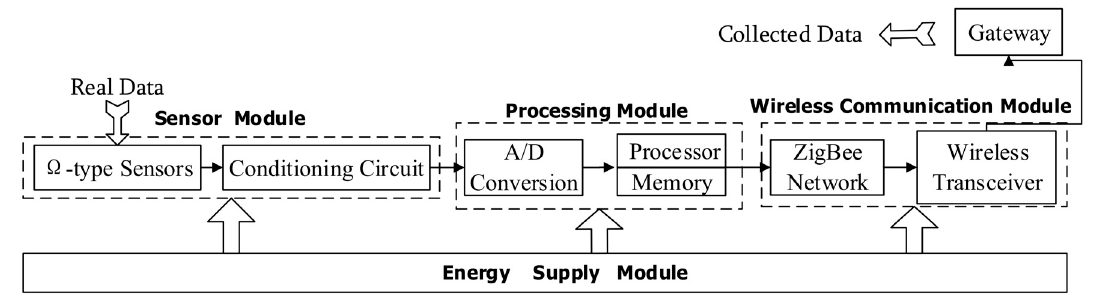
Figure 2. Data acquisition and transmission.